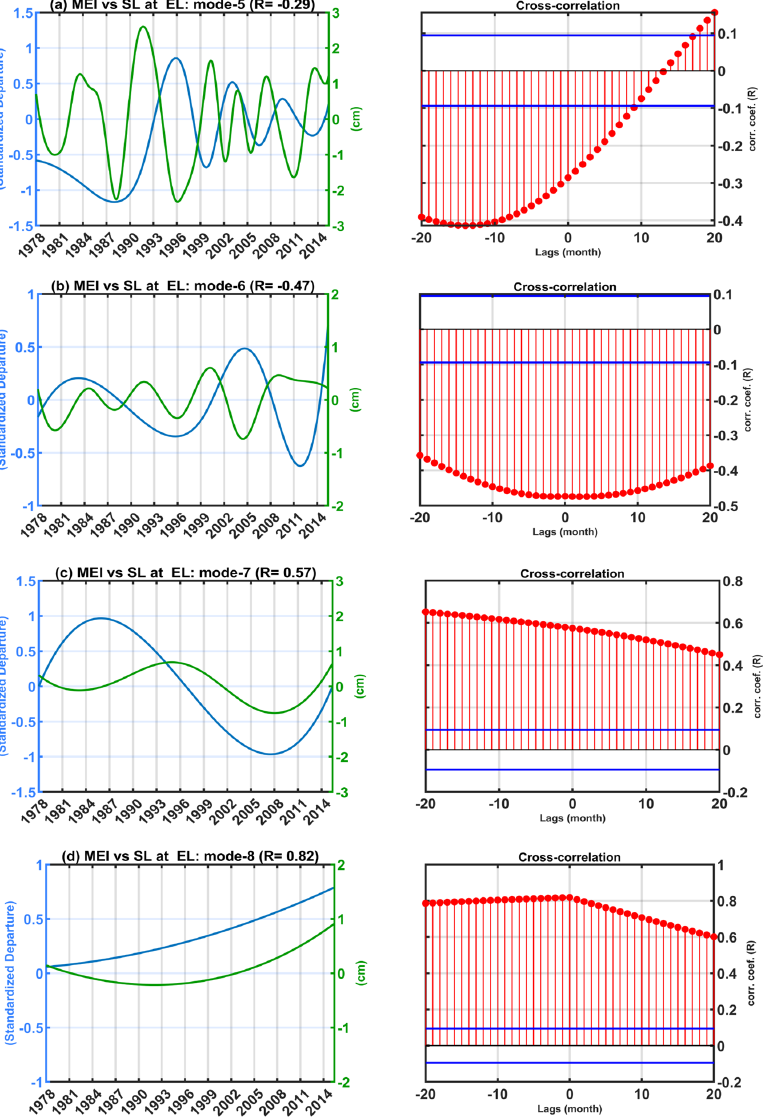
Figure 7. Correlation between monthly Multivariate ENSO Index and sea level at East London, on different timescales, separated by the EMD analysis. For a better comparison, the long-term linear trend and the seasonal cycle were removed from the original time series. Left panel, blue and green colours indicate the MEI and sea level (in centimeters), respectively. Right panel, the horizontal blue lines indicate the 95% confidence bounds. Mode 0 is the raw data, modes 1–7 are the oscillating modes, and the remaining residual mode is the trend (mode 8). On average, modes 5, 6 and 7 rep- resent approximately 4-, 7- and 19-year cycles, respectively.